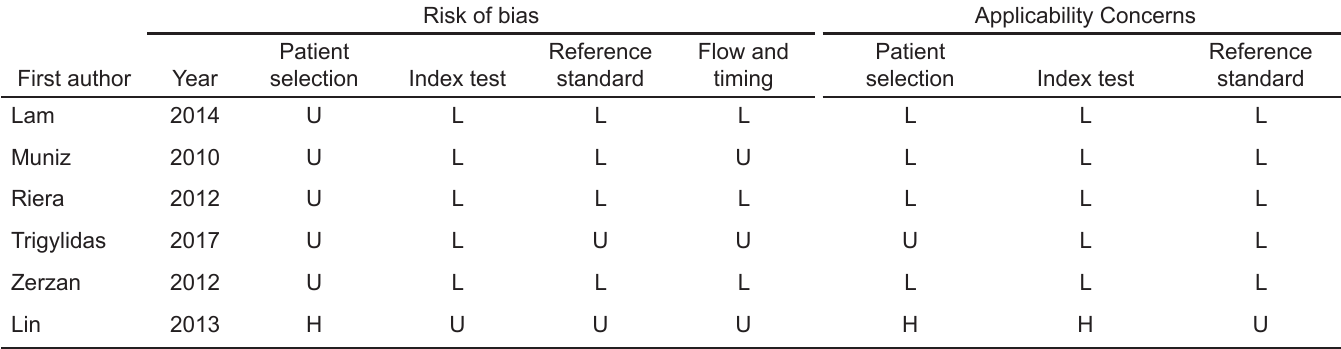
Table 3. Quality Assessment of Diagnostic Accuracy Studies-2 (QUADAS-2) for included